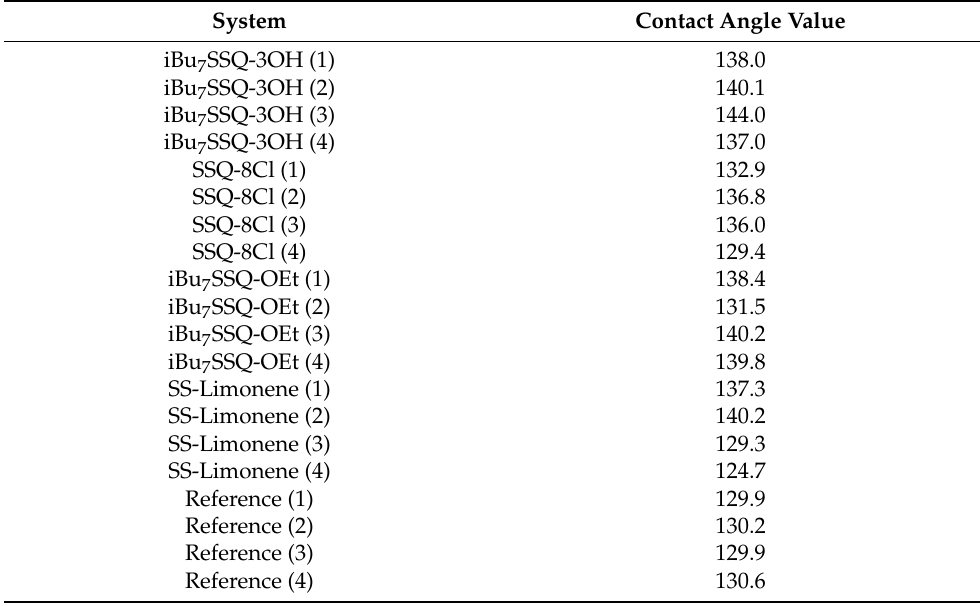
Table 4. Water contact angles of the prepared